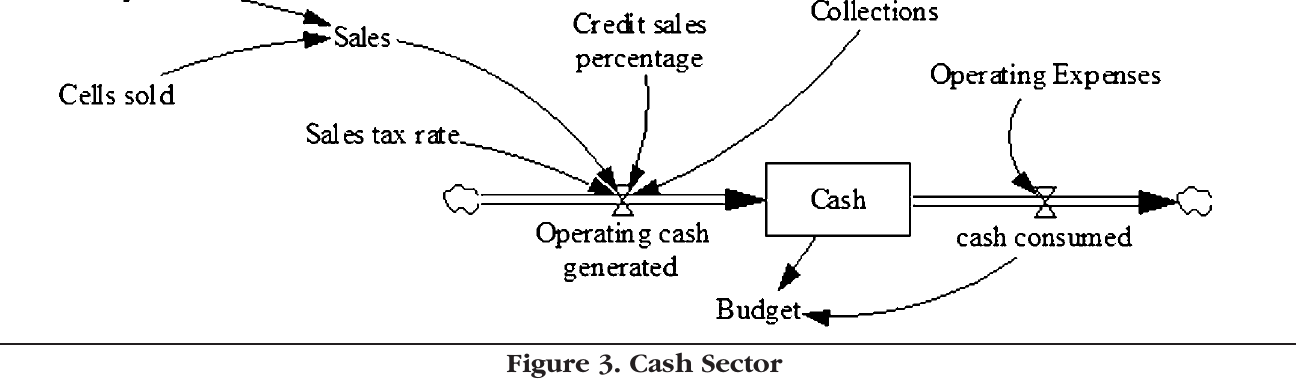
Figure 3. Cash Sector